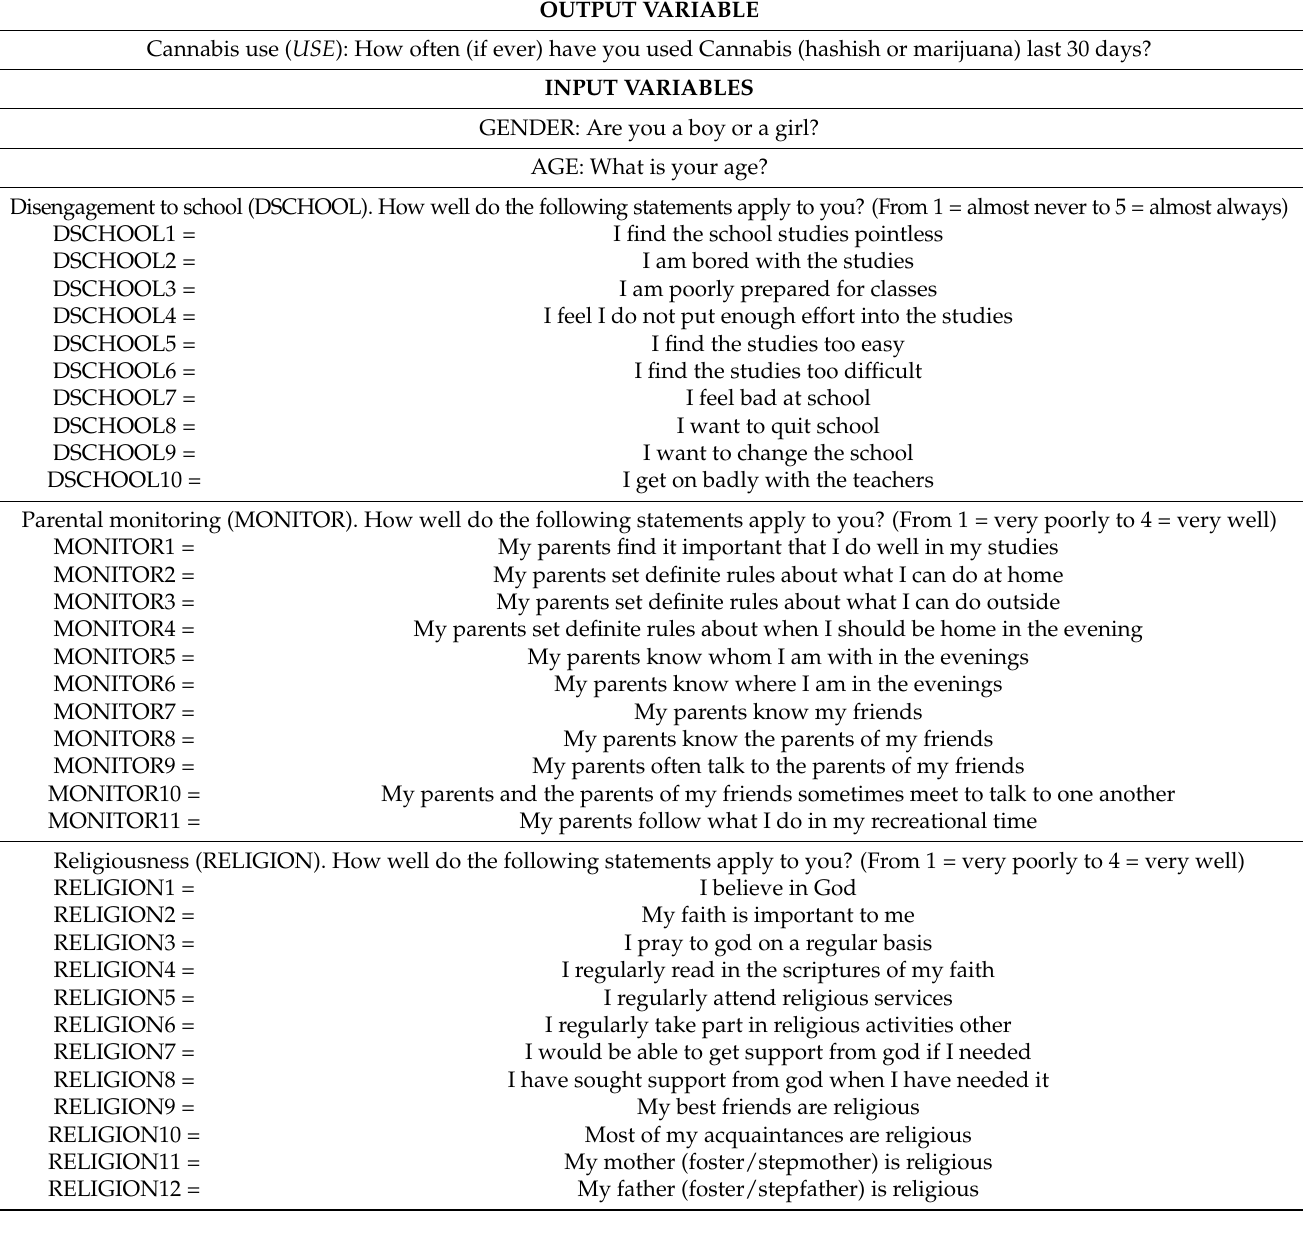
Table 1. Items of the